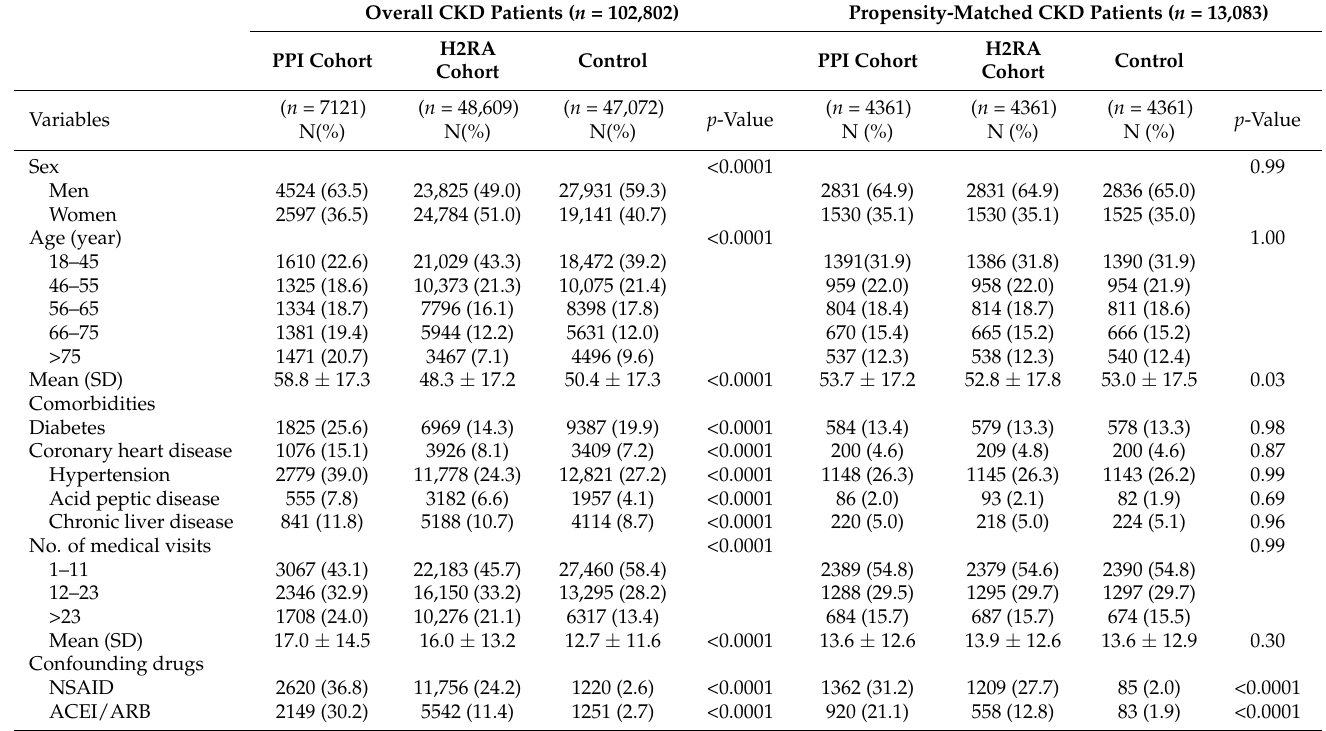
Table 1. Baseline characteristics of the three study cohorts in the CKD patients. Overall CKD Patients ( n = 102,802) Propensity-Matched CKD Patients ( n = 13,083)